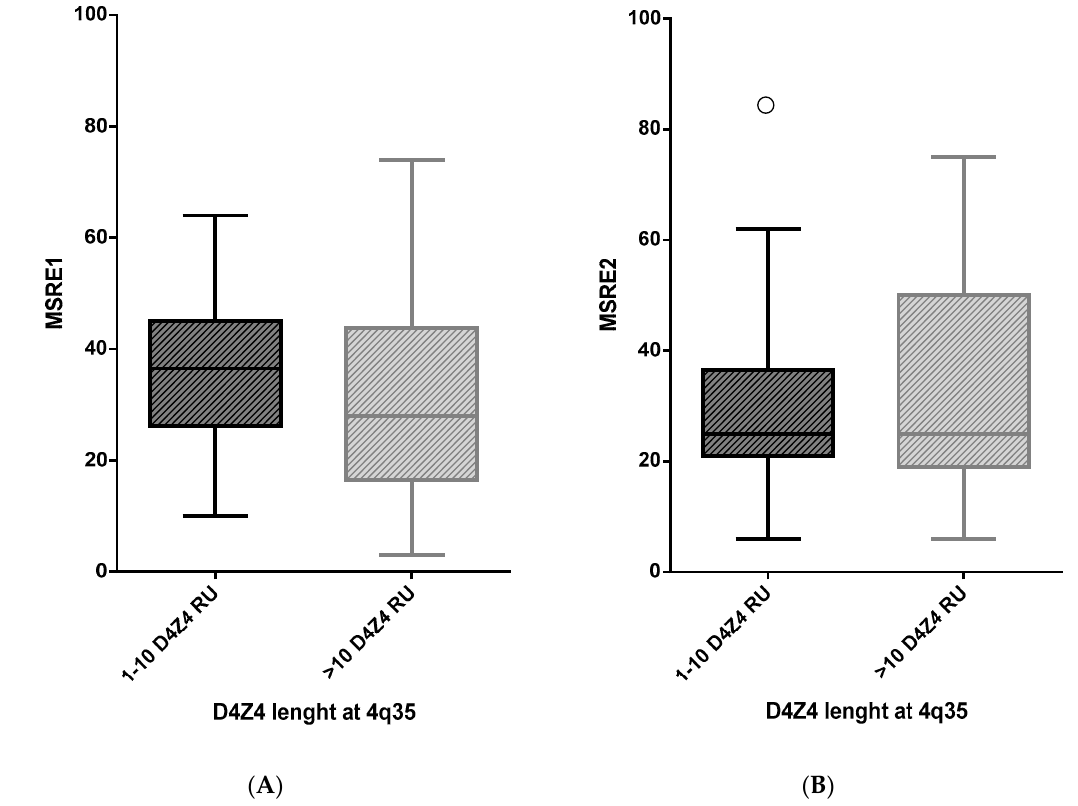
Figure 2. Comparison of D4Z4 DNA methylation level between FSHD index cases carrying 1–10 D4Z4 repeat units (RU) (FSHD1) or more than 10 D4Z4 RU (FSHD2): A box plot of D4Z4 methylation level assessed with MSRE1 ( A ) and MSRE2 ( B ) approaches in carriers of 1–10 or >10 D4Z4 units. The circle indicates an outlier value. Table 1. Mean D4Z4 methylation level and difference ( Δ ) in mean D4Z4 methylation between two groups reported in Figure 2.